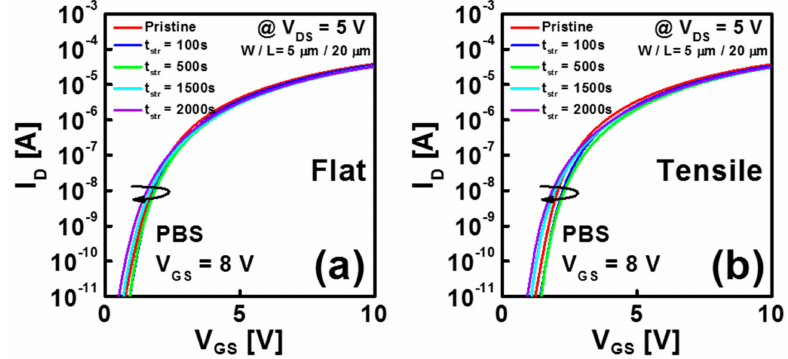
Figure 2. Change of transfer curves as a function of the applied stress time under a V GS stress of 8 V in flexible IGZO TFTs ( a ) at the flat state and ( b ) under the mechanical-bending